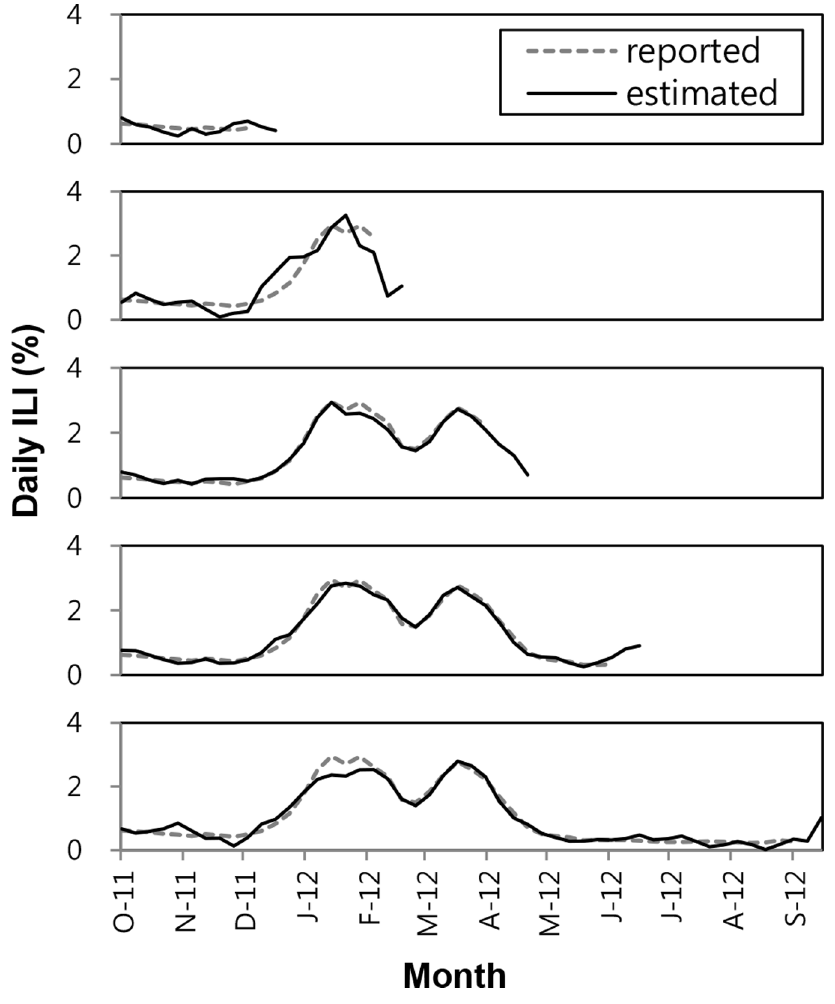
Figure 7. ILI percentages predicted by our model and provided by the KCDC for each month between Dec. 2011 to Sep. 2012. The data were compared at D ~ 7 and ~ DD ~ 11 .